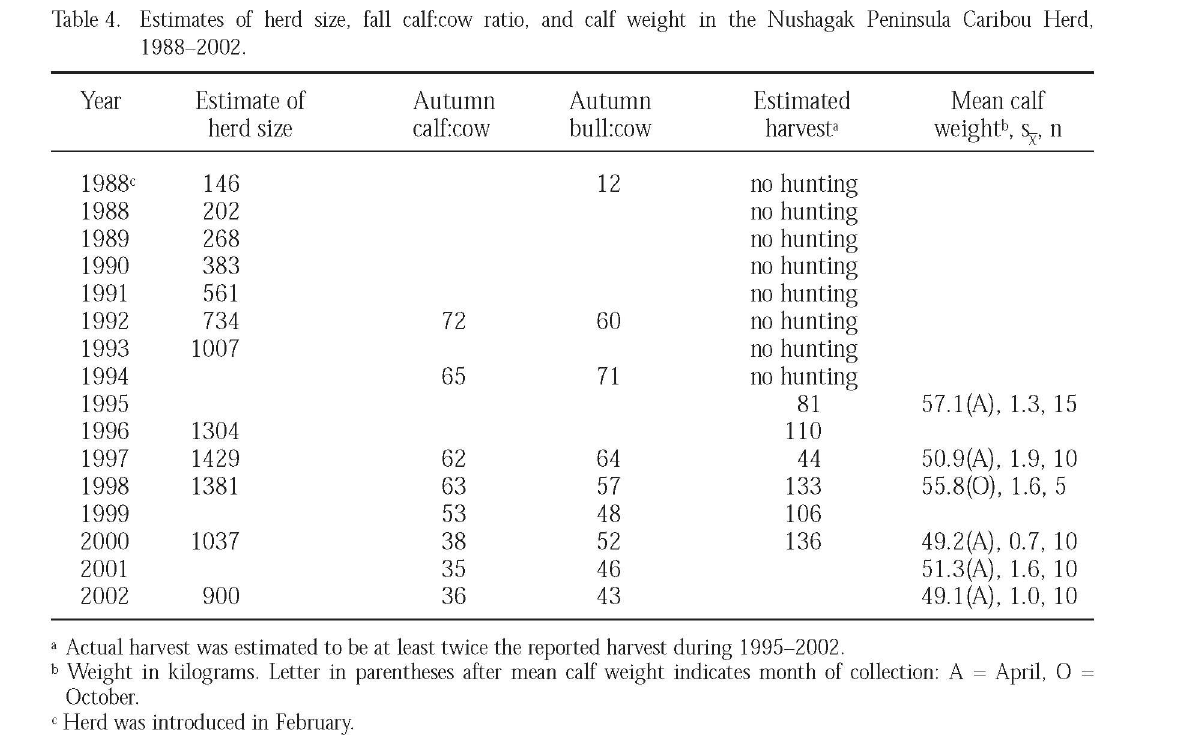
Table 4. Estimates of herd size, fall calfxow ratio, and calf weight in the Nushagak Peninsula Caribou Herd, 1988-2002. Year Estimate of Autumn Autumn Estimated Mean calf herd size calf:cow bull:cow harvest 8 weight b , s^,